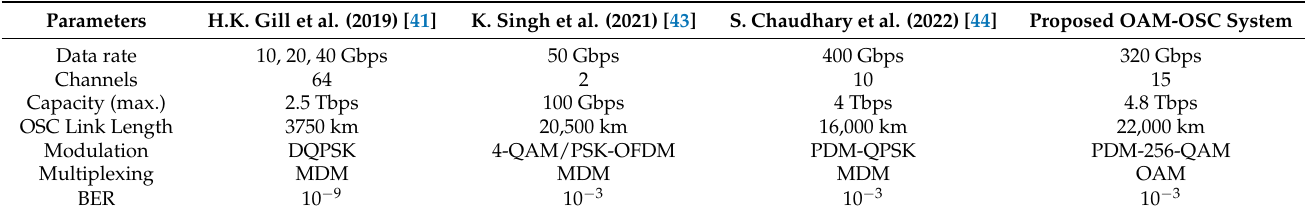
Table 2. Detailed comparison of proposed OAM-OSC and reported OS